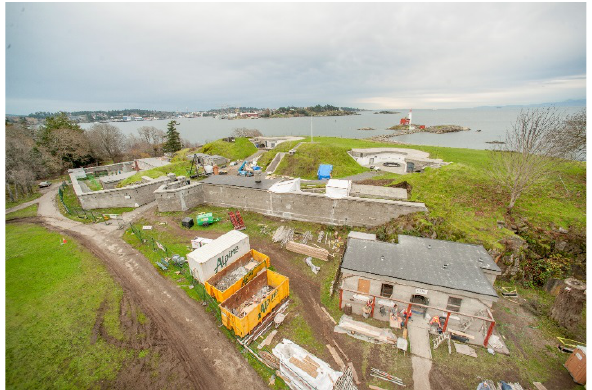
Figure 1: Aerial view of Fort Rodd Hill National Historic Site of Canada Lower Battery